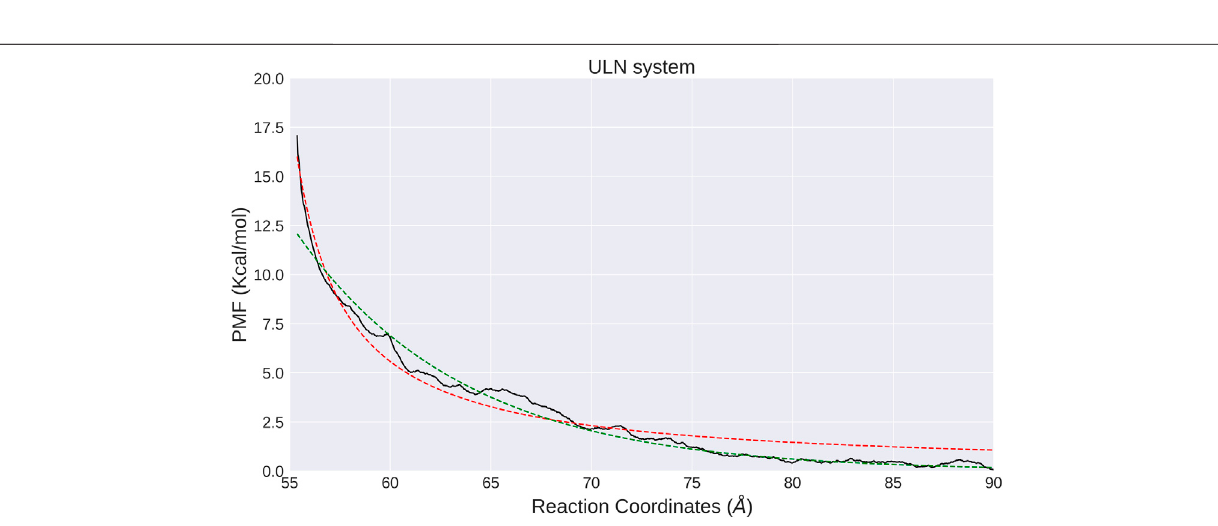
Frontiers in Molecular Biosciences |